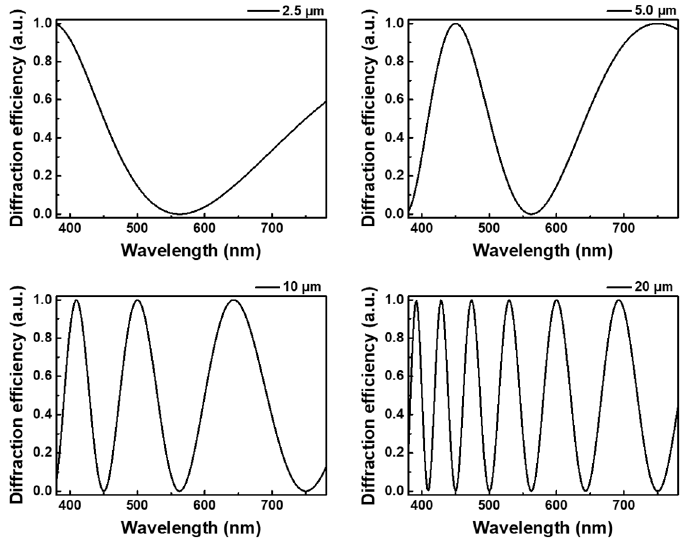
Figure 6. The diffraction efficiency of the ULH cells as a function of the wavelength of incident light with the cell gap of 2.5, 5, 10, and 20 μ m. The pitch of ChLCs were set as half of the cell gap.